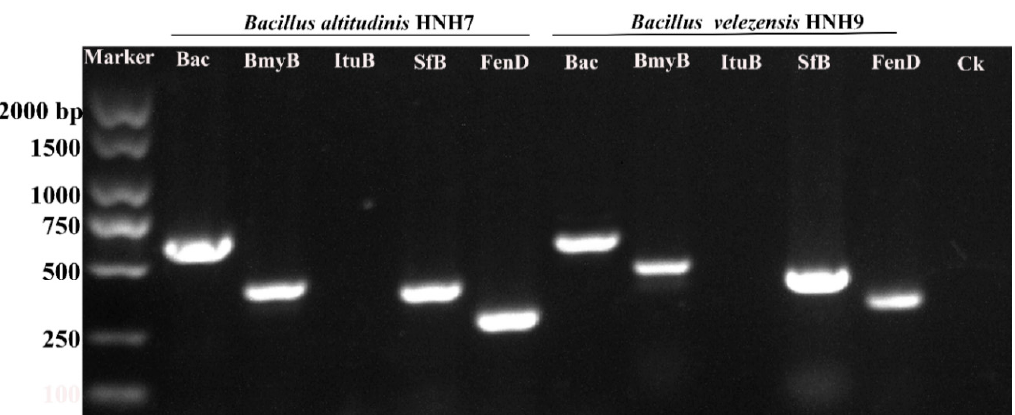
Figure 4. Genetic marker-assisted detection of antimicrobial compounds synthetase genes in HNH7 and HNH9. Bac = Bacillibactin, BmyB = Bacillomycin, ItuB = Iturin, SfB = Surfactin and FenD = Fengycin. Ck = Control.